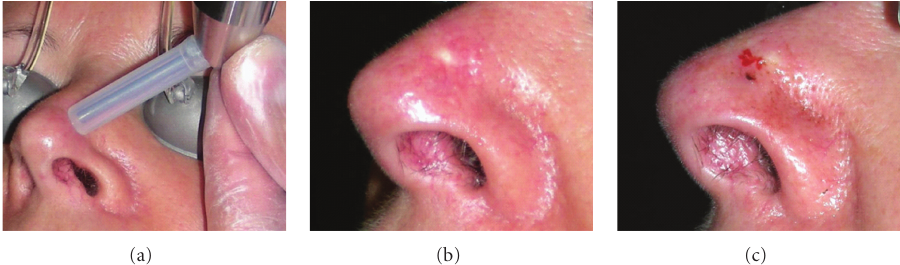
Figure 1: Experimental procedure. (a) Intradermal administration of ALA with a MadaJet medical injector; (b) lesion immediately post- Madajet and prior to the PDT procedure; (c) lesion after the PDT procedure.